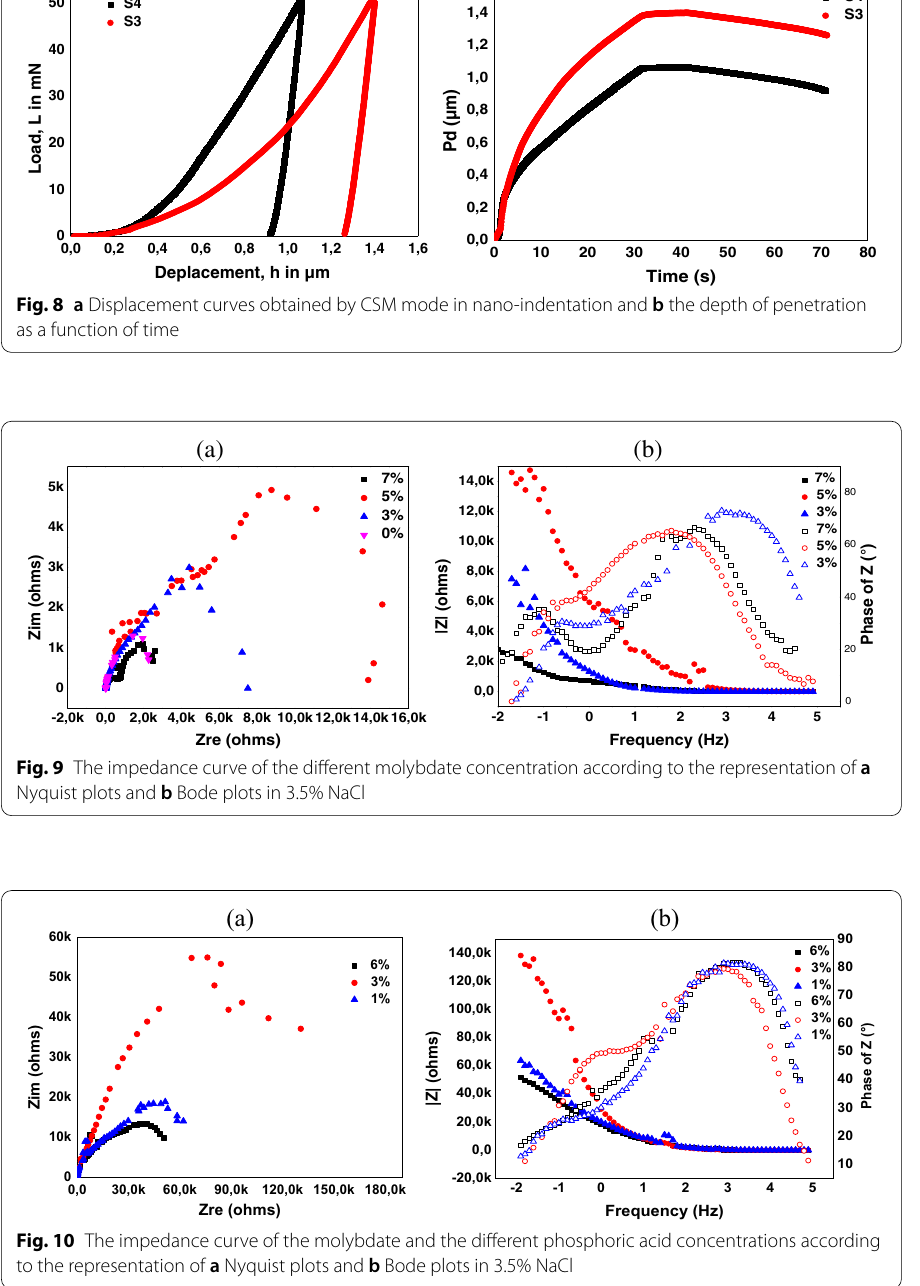
shows the impedance diagrams of the samples treated with 5% Mo and with a variation of the percentage of phosphoric acid. These show two capacitive loops in the high-fre- quency ranges for 6% and 1% phosphoric acid. The curve for 3% phosphoric acid shows a capacitive loop with the highest resistance part in the impedance diagram. Figure 11a is